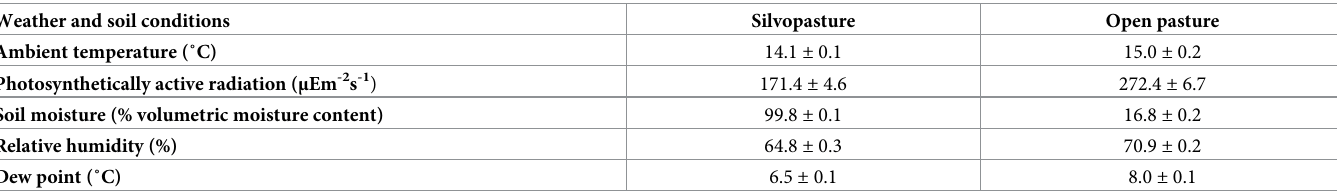
Table 2. Raw means ( ± SEM) of weather and soil conditions in the silvopasture and open pasture treatments from day 27 to day 43 in Experiment 1 (n = 2). Weather and soil conditions Silvopasture Open